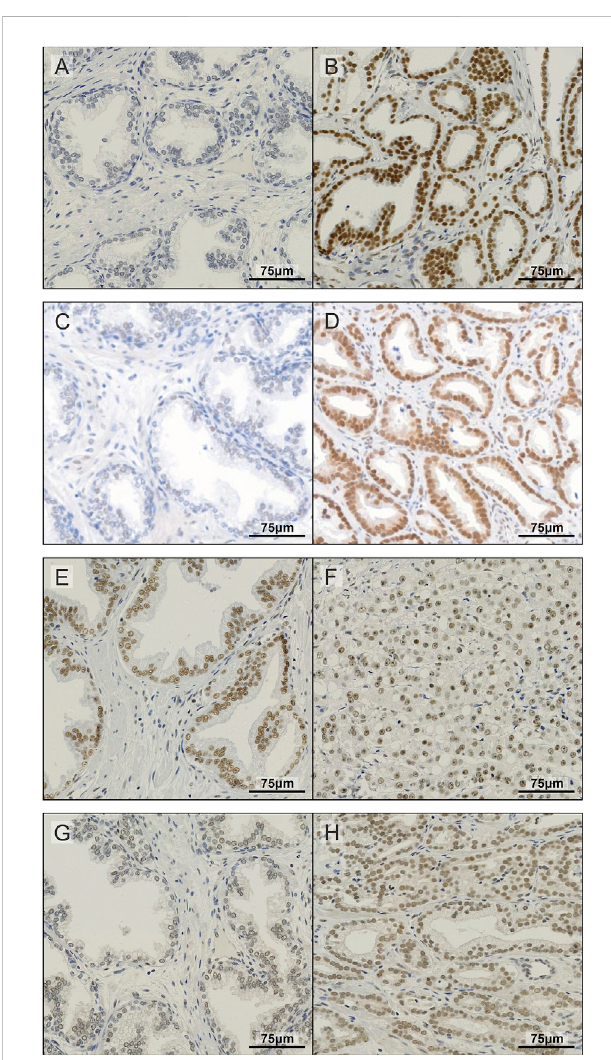
FIGURE 2 RepresentativeimagesofIHCstaininginprostateTMA.Examplesof non-malignant (A) and prostate tumour tissue (B) stained for METTL3; non-malignant (C) and prostate tumour tissue (D) stained for METTL14; non-malignant (E) andprostate tumour tissue (F) stained for WTAP; andnon-malignant (G) andprostatetumourtissue (H)